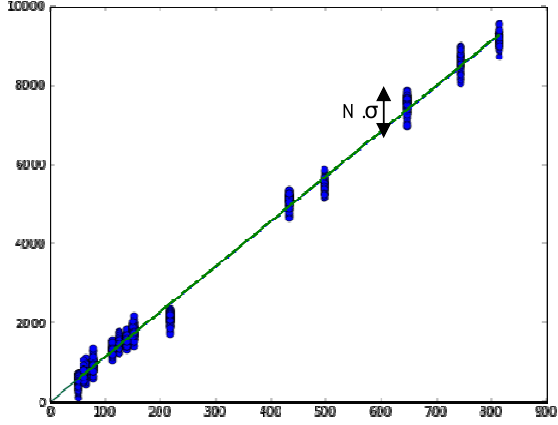
Figure 12 : Equivalent radiance vs. total numerical count